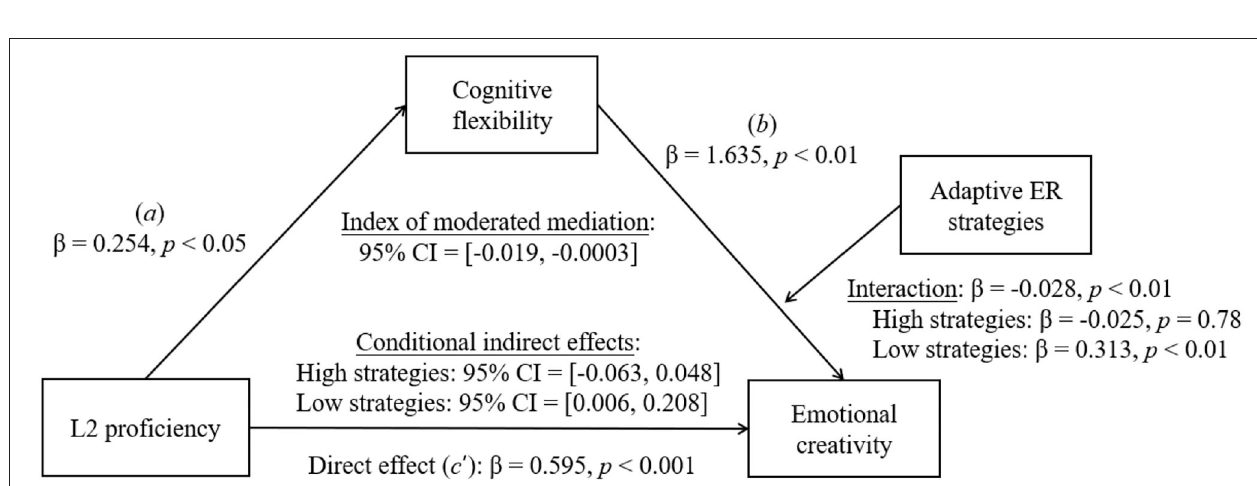
FIGURE 4 | Mediating role of cognitive flexibility in the association between L2 proficiency and CC (Model 4). The depicted is the path diagram of the simple mediation analysis showing the influence of L2 proficiency on the bilinguals’ CC through cognitive flexibility. Statistical results were satisfied for a mediation effect: Path a , Path b , Path c’ , and Path a × b ( β = 0.099, SE = 0.048, 95% CI = [0.013, 0.201]) were all significant.